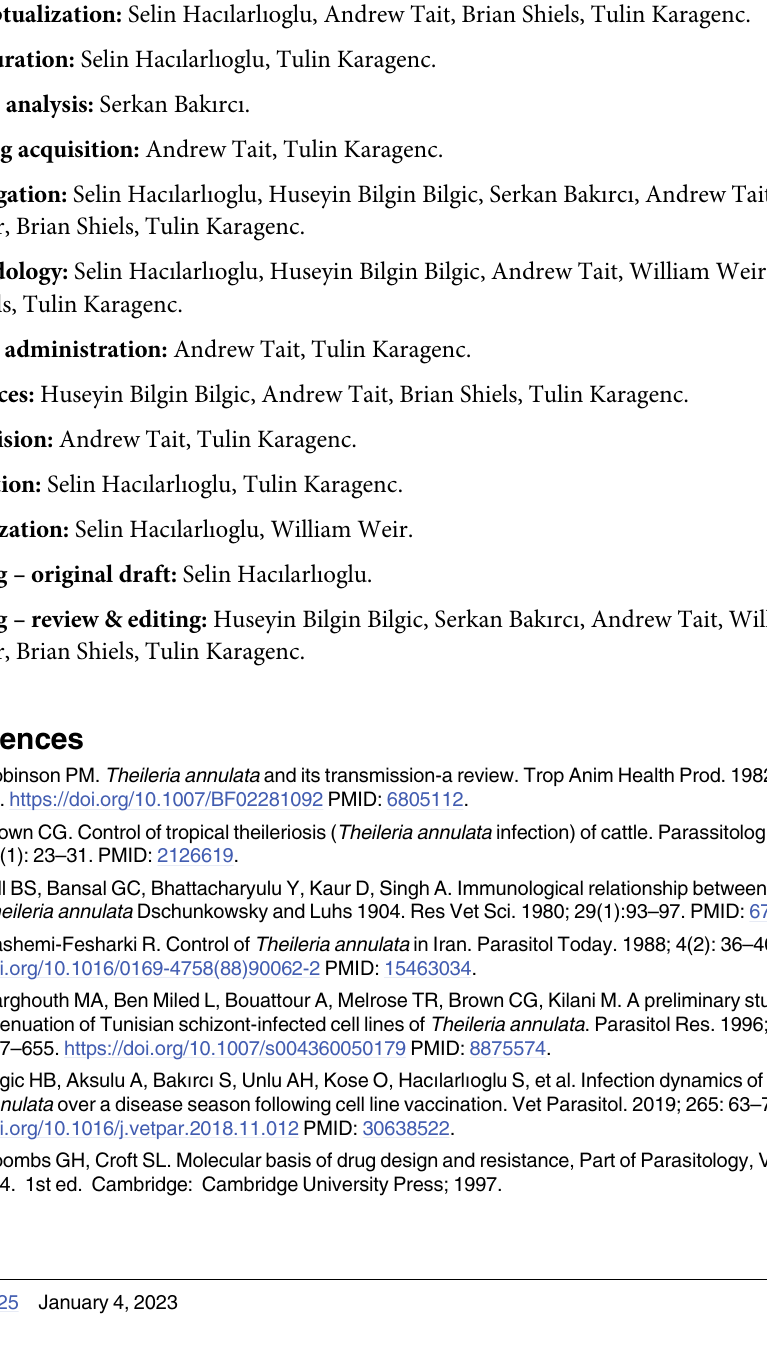
S2 Table. Summary of mutations detected in TaPIN1 sequences of T . annulata isolates from Tunisia, Sudan and Turkey. S3 Table. AS-PCR results of clonal cell lines. S4 Table. Summary of mutations detected in Cyto b sequences of T . annulata isolates from Tunisia, Sudan, Iran and